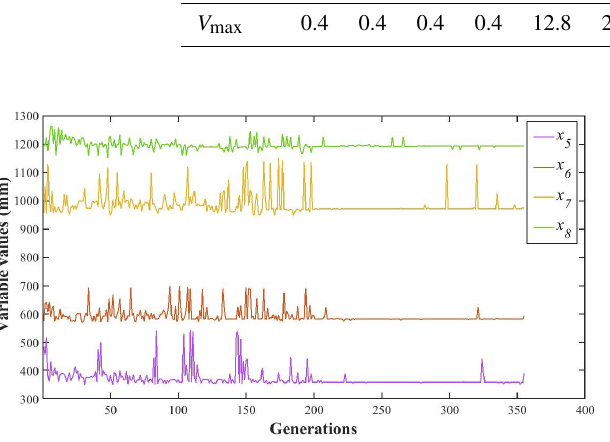
Figure 17. Variations of the design variables under different num- bers of generation.